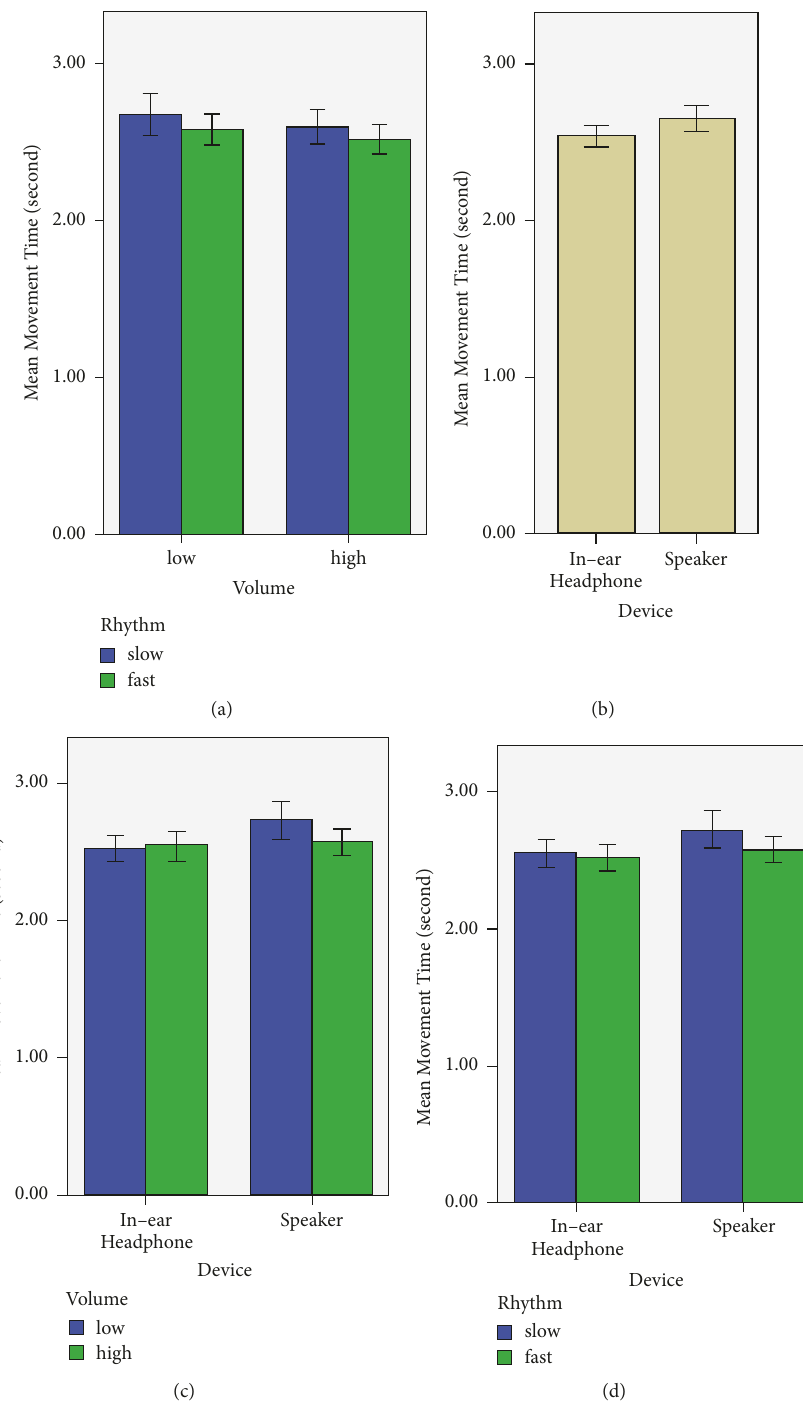
Figure 9: Mean movement time for (a) Volume × Rhythm; (B) Device; (C) Device × Volume; (D) Device × Rhythm.